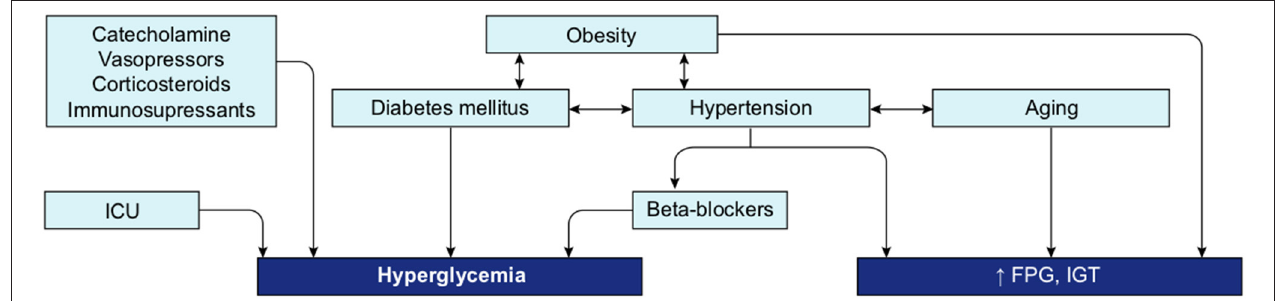
FIGURE 10 | Interconnection of groups at-risk and their link with dysregulation of blood glucose metabolism. Hyperglycemia, increased FPG or IGT (impaired glucose tolerance) are glucose metabolism dysregulation observed in the different group at risk for COVID-19. Hyperglycemia is the define characteristic of DM. ICU is associated with stress induced hyperglycemia. Hypertension, obesity and aging are all conditions strongly linked to increased FPG or IGT. Beta-blockers, used as treatment for hypertension or drugs used in ICU may also induce hyperglycemia. Additionally, obesity is a comorbidity often associated with DM and hypertension.